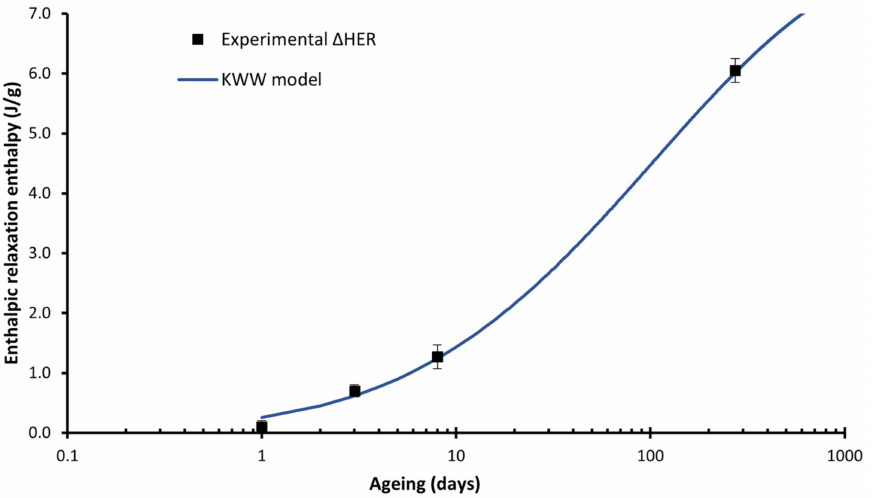
Figure 7. Enthalpic relaxation enthalpy for the material 19 00 and the corresponding KWW fitting model (line). The line represents the KWW model, the dots the experimental